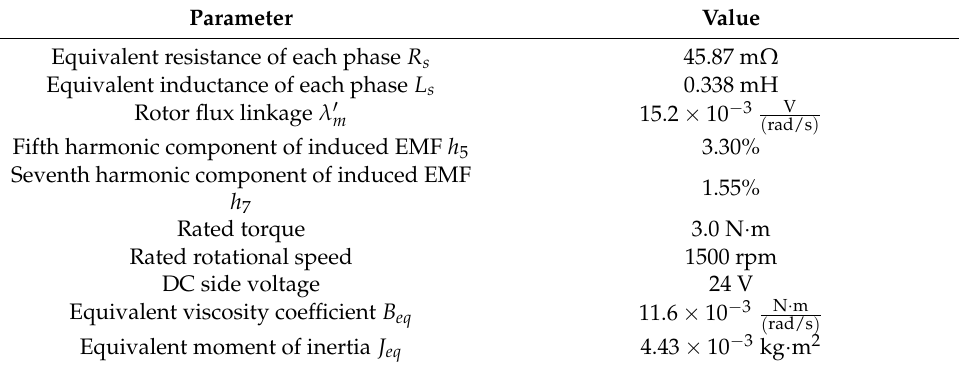
Table A1. Measured results of three-phase permanent-magnet synchronous motor